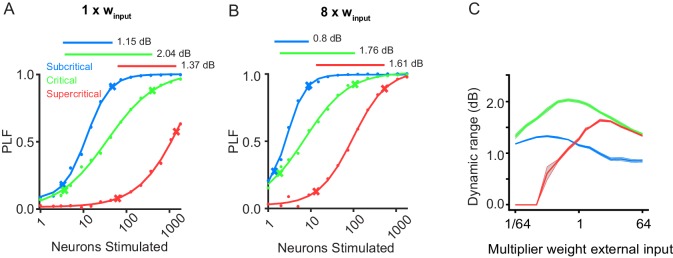
Critical networks show maximal dynamic range of phase-locking factor.(A) Replication of Figure 1D for comparison purposes. (B) Multiplying stimulus weight by 8, allows the response of super-critical networks to saturate. (C) Dynamic range of PLF for 10 network initializations of the example critical (green), subcritical (blue), and supercritical (red) networks, for different levels of the external input strength (ranging between 1/64 and 64 times the baseline value, winput = 0.0085). Lines denote mean dynamic range, and the gray ribbon represents standard error.